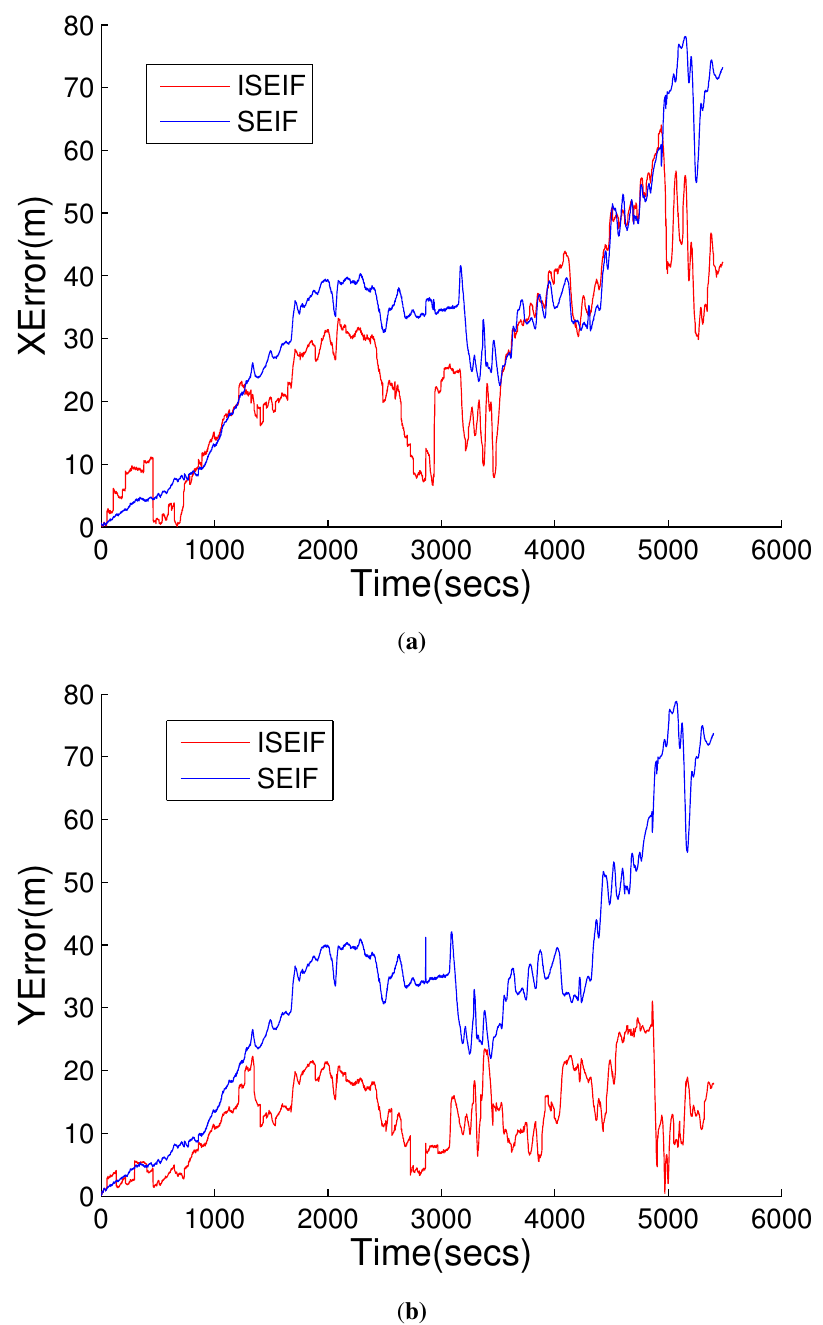
Figure 15. The RMS error comparison between SEIF and ISEIF relative to GPS, where ( a ) is the error in horizontal coordinate and ( b ) is in vertical